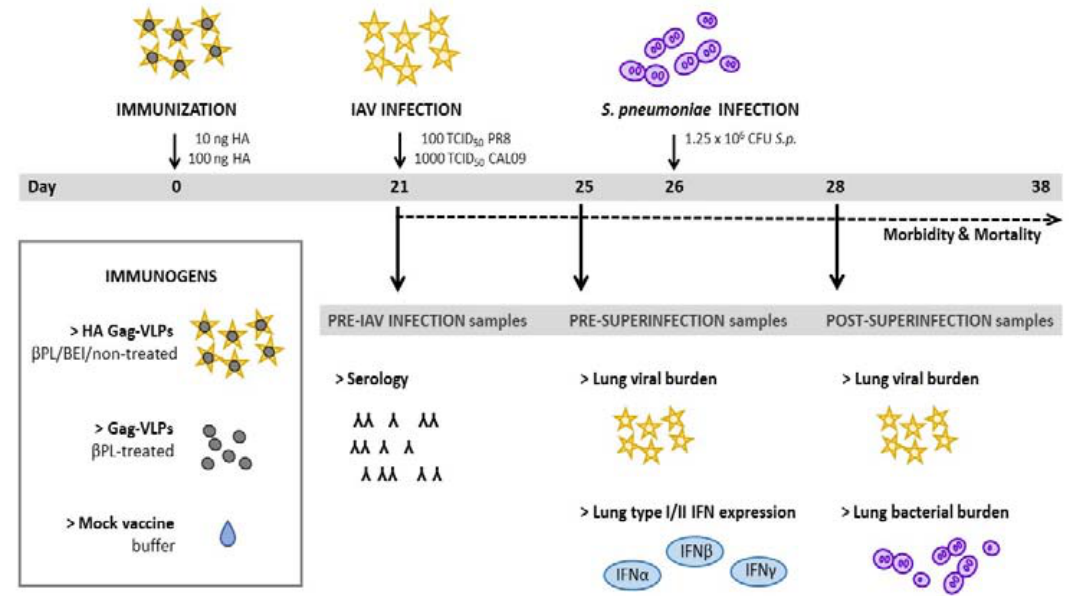
five animals were sacrificed for the assessment of innate immune activation at the vaccination site by analysis of type I / II interferon expression in peritoneal washes (see Section 2.9). To evaluate the e ffi cacy of neutralizing or non-neutralizing influenza HA immunity in the context of secondary pneumococcal infections, animals were immunized and infected as per the study design, given in Figure 1. Four groups of animals were used for the assessment of neutralizing influenza HA-immunity in the context of secondary pneumococcus infections. There, mice were immunized with β PL-or BEI-treated HA-Gag Gag-only control VLPs normalized for the total protein content of HA-Gag VLPs (termed Gag only , n = homologous influenza virus PR8 followed by bacterial infection with 1.25 × 10 6 CFU S. pneumoniae five days later. Six groups of animals were employed for the assessment of non-neutralizing influenza HA-immunity after influenza-pneumococcal superinfections. Among this set of mice, four groups of 25–26 animals received β PL- or BEI-treated HA-Gag VLPs at a low (10 ng HA, termed β PL low , or BEI low ) or a high antigen dose (100 ng HA, termed β PL high , or BEI high ). Control groups received = 21) normalized for the total protein content of to β PL-treated Gag-only VLPs (termed Gag only , n the low dose groups or were mock-immunized with bu ff er [termed ( − ) vacc , n = 24]. Twenty-one days post immunization mice were challenged with 1000 TCID 50 of a heterologous influenza H1N1 virus (CAL09) followed by bacterial superinfection with 1.25 × 10 6 CFU S. pneumoniae five days later.